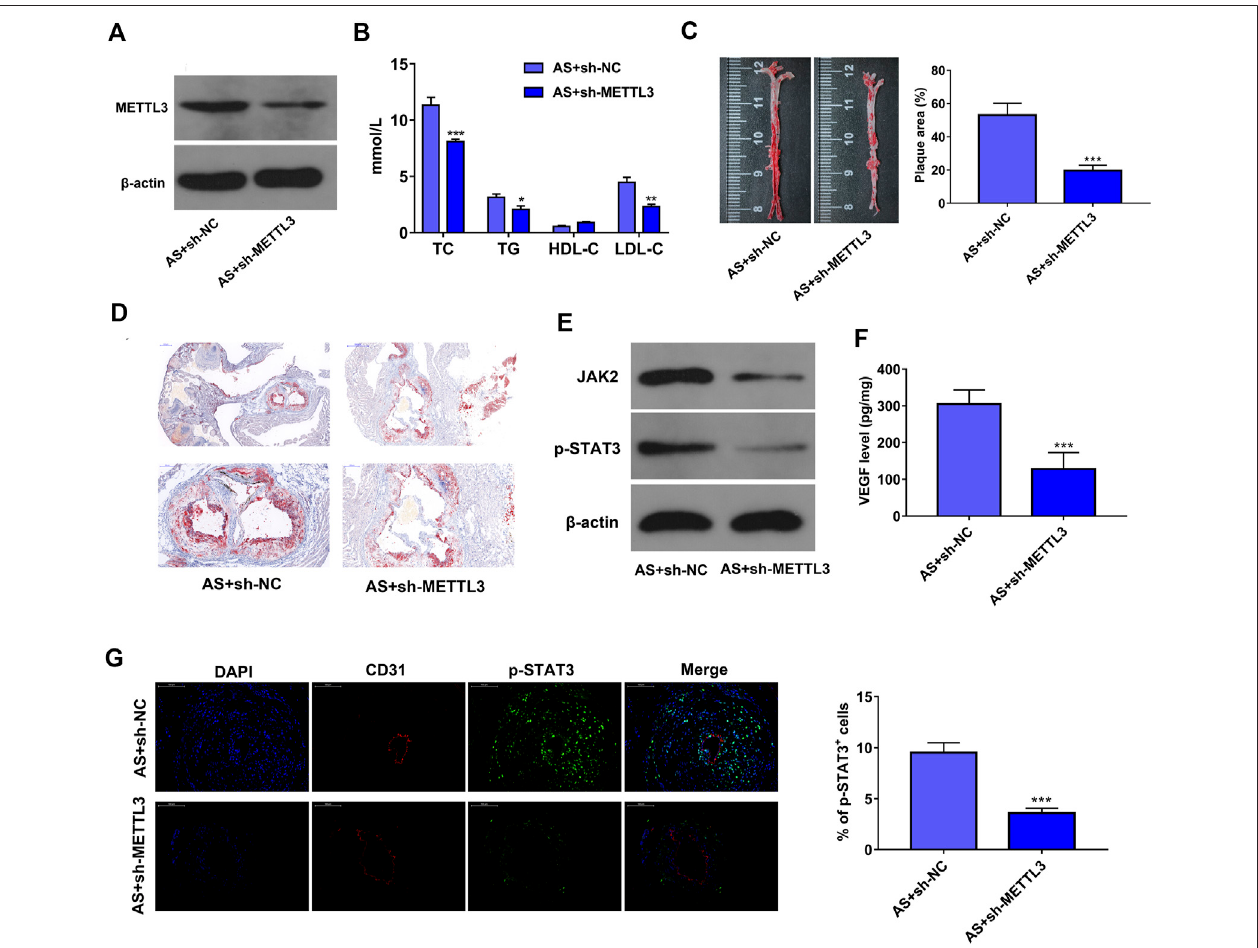
FIGURE6| METTL3knockdownhamperedASprogressionbyinhibitingJAK2/STAT3pathway invivo . (A) ProteinlevelofMETTL3inASlesionswasmeasuredby westernblotassay(n (cid:1) 5). (B) TheplasmalevelsofTC,TG,HDL-C,andLDL-Cweremeasuredthroughcorrespondingkits(n (cid:1) 5). (C) Representativeimagesofthetotal aorta stained with Oil Red O, and the estimation of AS lesion area (n (cid:1) 5). (D) Representative images of aortic valve sections stained with Oil Red O (n (cid:1) 5). (E) Protein levels ofJAK2 and p-STAT3in AS lesions were measured by western blot assay (n (cid:1) 5). (F) VEGF secretion level in the lesions wasexamined through ELISA assay (n (cid:1) 5). (G) Protein levels of p-STAT3 in AS lesions were measured by IF assay (magni fi cation: × 200, n (cid:1) 3). Previously frozen mice samples were used to measure the level of JAK2 and p-STAT3. * p < 0.05, ** p < 0.01. *** p < 0.001.